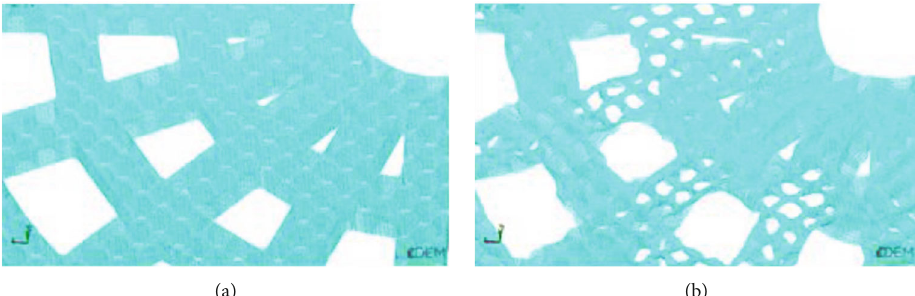
Figure 18: Deformation of bonding structure before and after compression of spider web honeycomb. (a) Cobweb honeycomb structure before compression. (b) Cobweb honeycomb structure after compression.